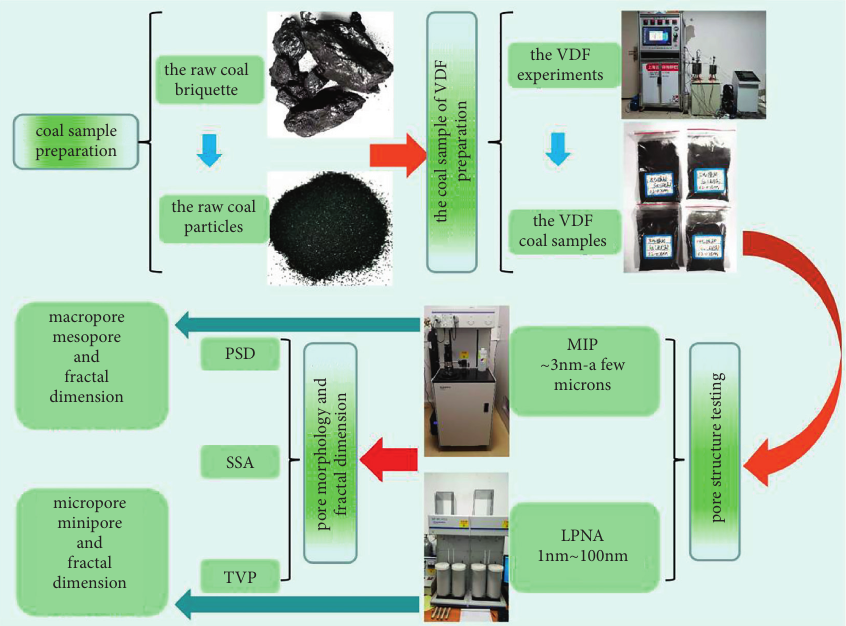
Figure 1: Experimental scheme to study the spatial characteristics and surface morphology of pores and fissures under VDF